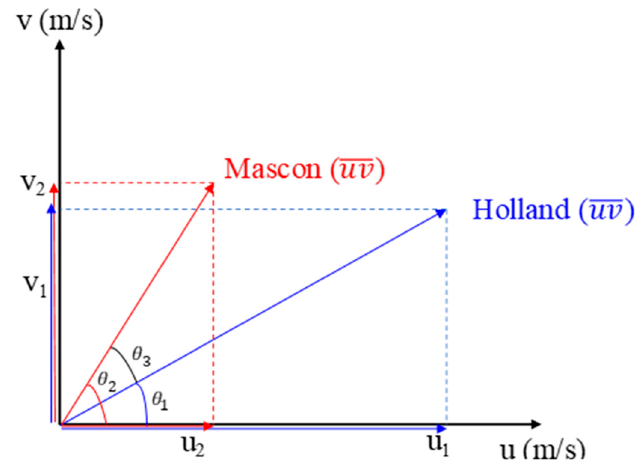
Figure 12. Wind velocity change rate in the topography of mesh (2700 m).